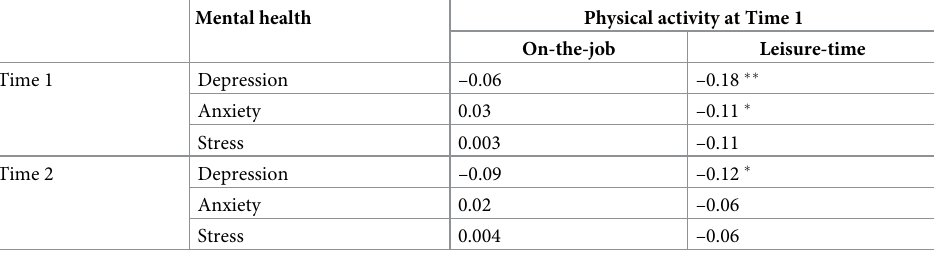
Table 3. Pearson correlations between physical activity at Time 1 and mental health at Time 1 and Time 2 ( n = 319).